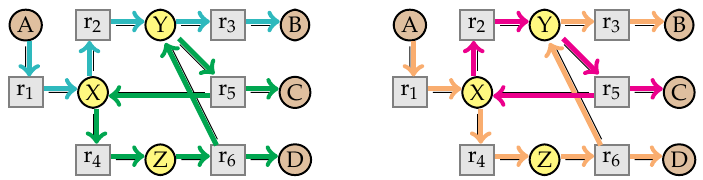
Figure 23. Two decompositions of the mode ( 1,1,1,1,1,1 ) in the network W